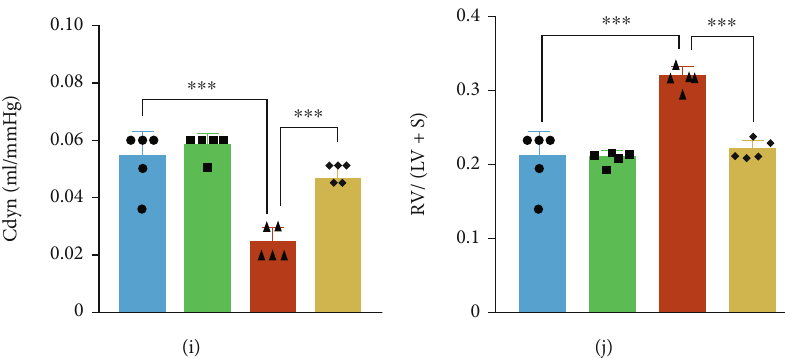
Figure 2: hUCMSC treatment attenuates lung morphology and function in the IA-LPS BPD model. (a) The study design represents the IA-LPS BPD model and hUCMSC treatment. Transtracheal administration of hUCMSCs was conducted on PN7. Study end points on PN14 involved analysis of lung morphology, function, and right ventricular hypertrophy (RVH). (b) Representative lung sections stained with H&E on PN14, scalebar = 200 μ m. (c) Quanti fi cation of MLI ( N = 5 , ANOVA, ∗∗∗ P < 0 : 001 ). (d) Quanti fi cation of radial alveolar counts (RAC) ( N = 5 , ANOVA, ∗∗∗ P < 0 : 001 ). (e) Comparison of pups ’ weight among four groups ( N = 5 , ANOVA). (f) Representative immuno fl uorescence images of vWF staining in the lung on PN14 in each group, scalebar = 100 μ m. (g) Quanti fi cation of vWF-positive vessels ( < 100 μ m) ( N = 5 , ANOVA, ∗∗ P < 0 : 01 and ∗∗∗ P < 0 : 001 ). (h) Lung resistance (LR) and (i) dynamic compliance (Cdyn) were determined from anesthetized and ventilated pups ( N = 5 , ANOVA, ∗∗∗ P < 0 : 001 ). (j) The right ventricular index was determined by RV/LV + S to measure RVH ( N = 5 , ANOVA, ∗∗∗ P < 0 : 001